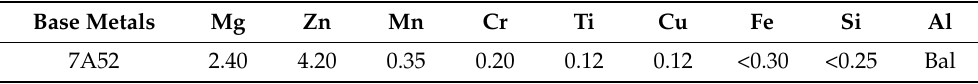
Table 1. 7A52 aluminum alloy main chemical composition (mass